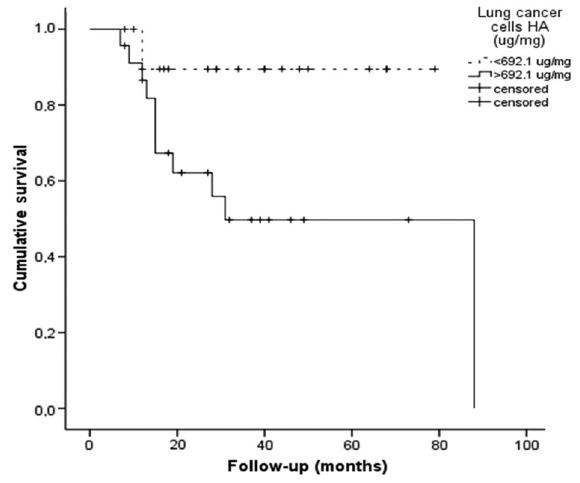
Figure 3. Kaplan-Meier plots of survival probability vs follow-up time in months for all patients. The group with , 692.1 m g/mg HA appears as the top curve, and the group with > 692.1 m g/mg HA appears as the bottom curve.